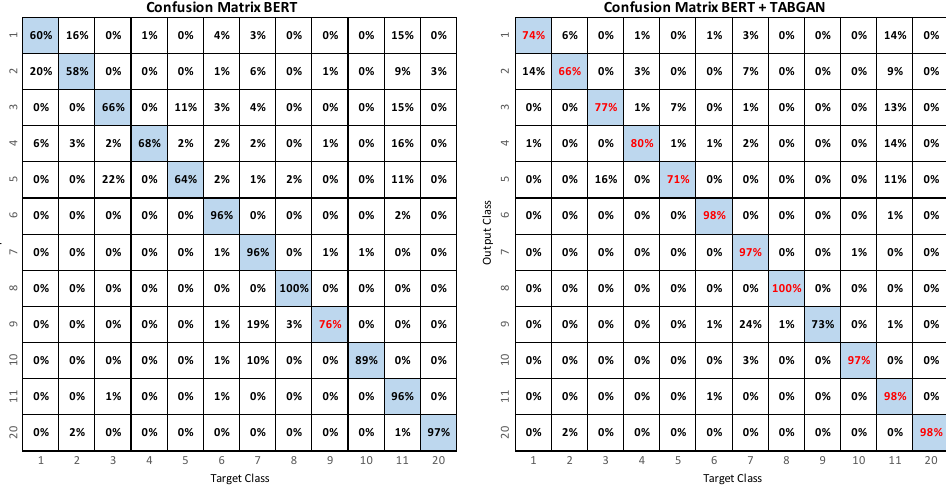
Figure 9. Confusion matrices for activity recognition using BERT ( left ) and BERT+TABGAN ( right ). The best results are shown in